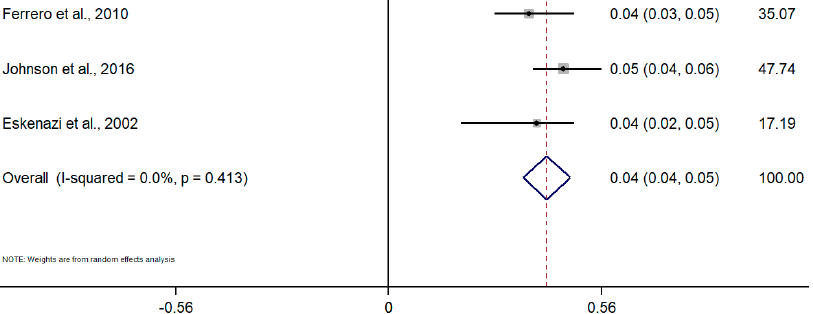
Figure 4. Meta-analysis of the prevalence of endometriosis based on studies using data from other sources. Note: black lines with squared dots—the prevalence with confidence intervals for each individual study; rhombus—pooled prevalence with confidence interval; red dotted line—line of no effect (studies crossing the line are not statistically different). Healthcare 2021 , 9 , x